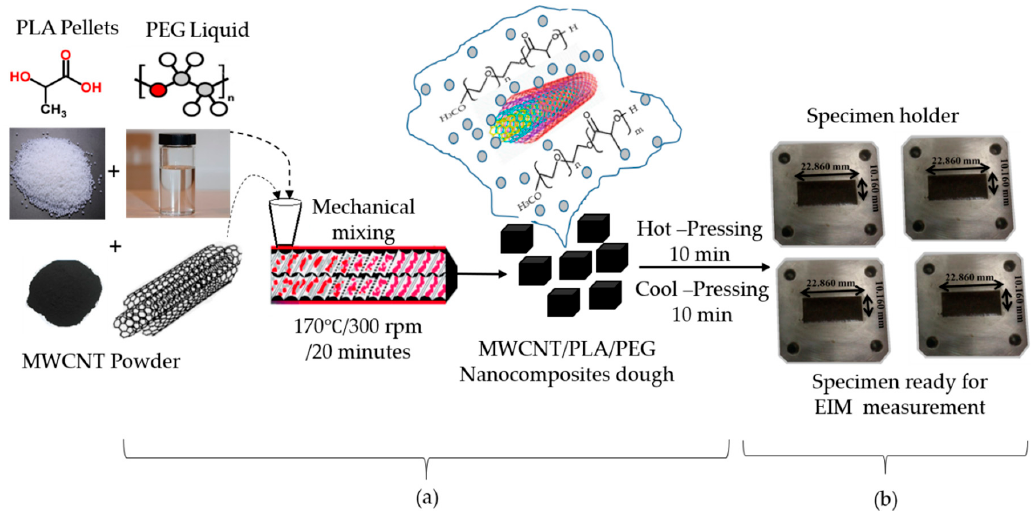
Figure 2. Schematic representation illustrating ( a ) the preparation of MWCNT/PLA/PEG nanocomposites, Chemical structure of materials as- preparation, and ( b ) MWCNT/PLA/PEG rectangular specimens fit inside the sample holder for electromagnetic interference (EMI) measurement. Table 1. The compositions of the nanocomposites.